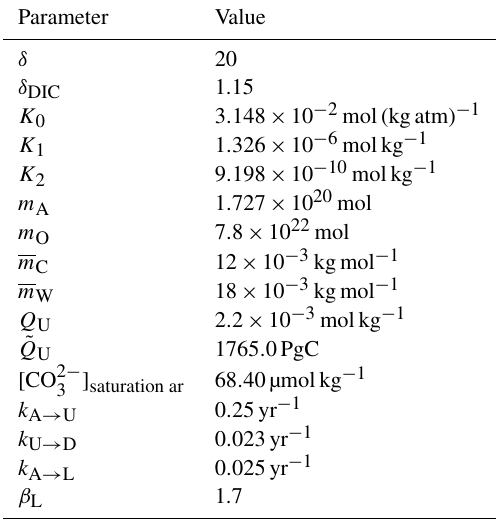
Table 1. Parameter values for the carbon cycle model.